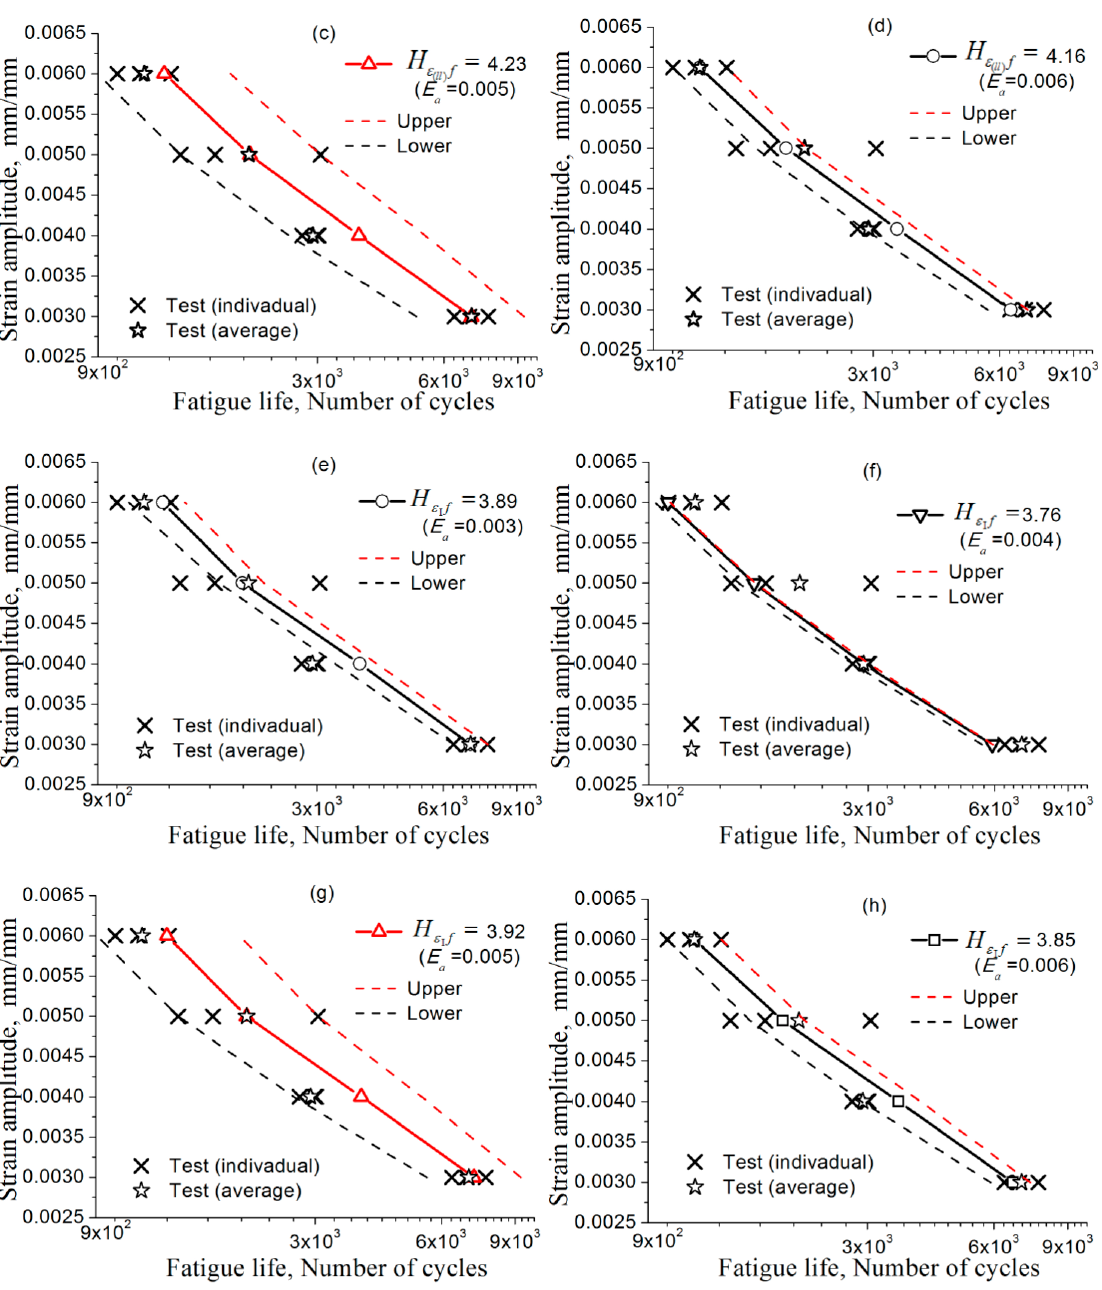
E ~ N Figure 6. Predicted fatigue-life curves a f with the upper and lower estimations based on: ( a – Figure 6. Predicted fatigue-life curves E a ∼ N f with the upper and lower estimations based on: ( a – d ) H ε and ( b – h ) H ε . The test data in this figure are cited from literature [53] (see Table H ( ll ) f I f d ) f ε and ( b – h ) ll )(